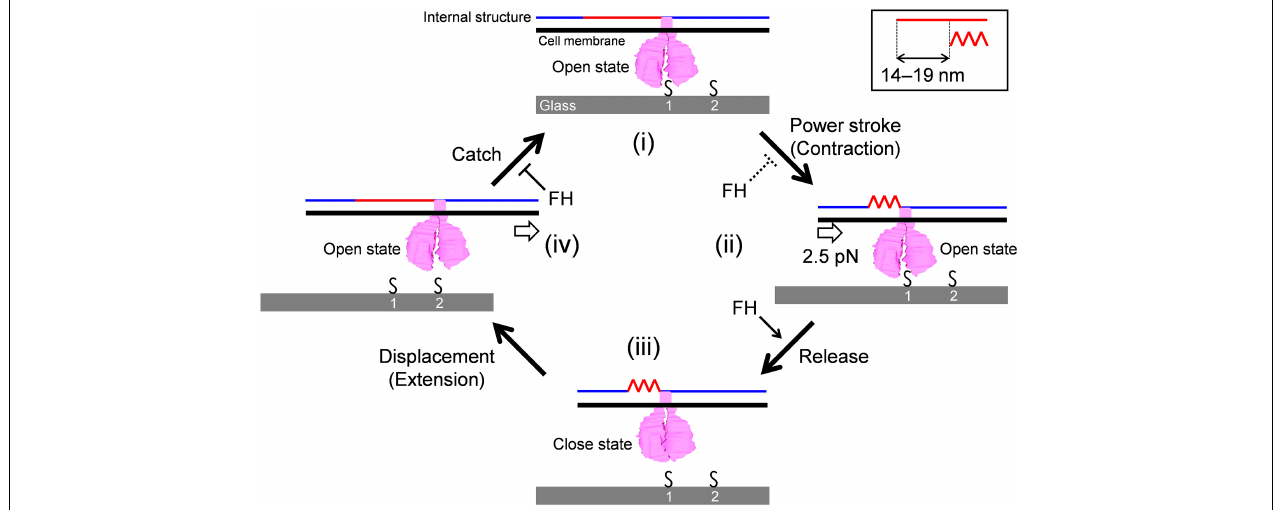
FIGURE 6 | Schematic illustration of leg behaviors in stepwise movements. Internal structure presented by blue and red lines is responsible for force transmission. It repeats contraction and extension cooperatively with the surface structures. Conformational change of internal structure and step size are shown in a right-upper box. GPCA is presented in pink. Sialylated oligosaccharides are shown by “S.” Force exerted in a step is shown by an arrow in panel (ii). Displacement of cell body forward is shown by an arrow in panel (iv). The gliding occurs through stages (i)–(iv). See the text for details.